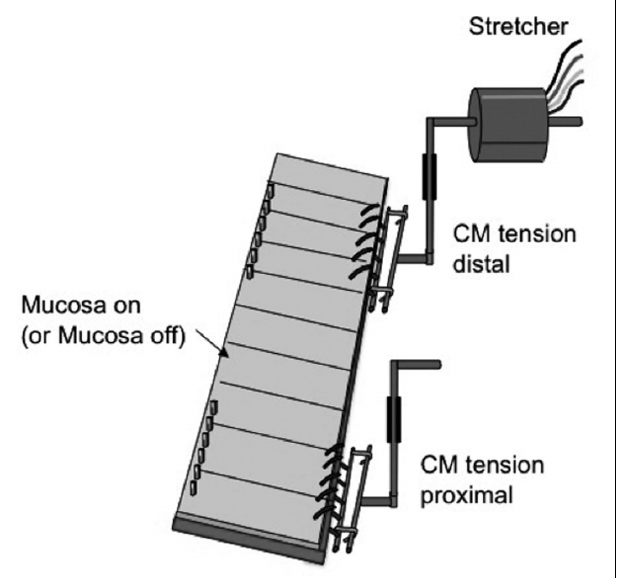
FIGURE 1 | Diagrammatic representation of the preparation used to elicit and record distension-evoked CMMCs. A stepper motor controlled tissue stretcher was used to apply controlled distensions to a 15-mm segment of distal colon. In the proximal colon, an isometric tension transducer was used to record dynamic mechanical activities of the oral region of colon. Stretch was only applied to distal colon.